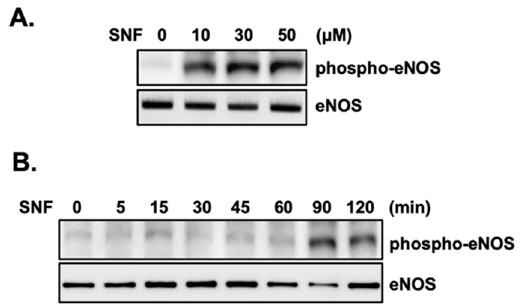
Figure 3. SFN increases the phosphorylation of eNOS in a concentration- and time-dependent fashion in EA.hy926 cells. The cells were treated with various concentrations of SFN for 1 h ( A ) or 50 µ M SFN for the indicated time ( B ). Cell lysates were examined by Western blot using antibodies to eNOS or phosphorylated eNOS. The blots are representative of three independent assays.